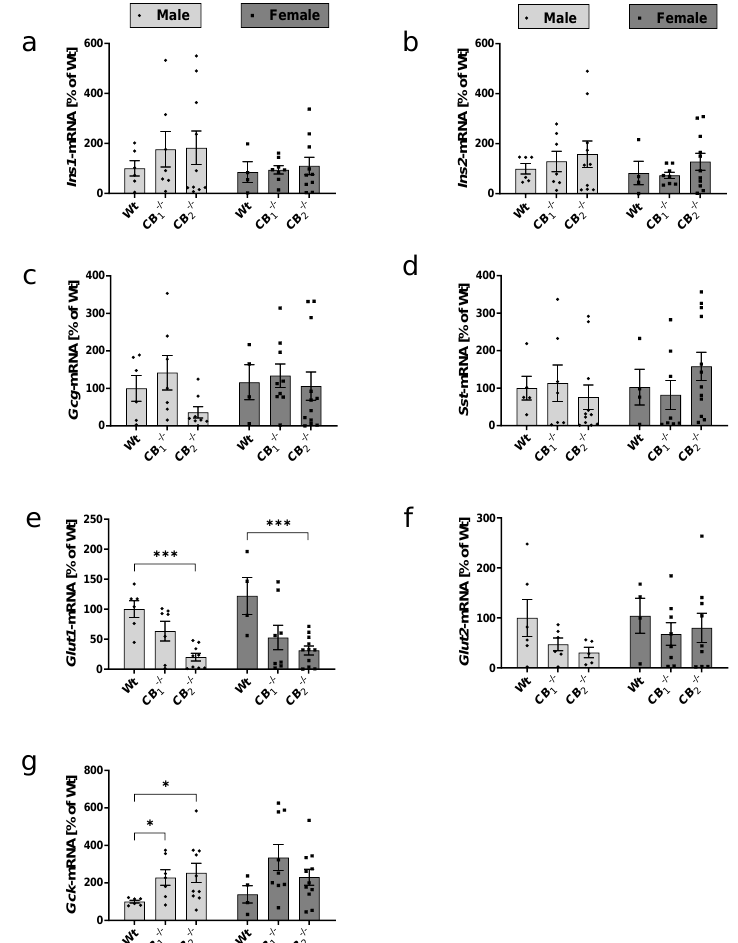
Figure A1. Transcript analysis by real-time RT-PCR of the pancreatic islet hormones ( Ins1 , Ins2 , Gcg and Sst ), glucose transporters ( Glut1 , Glut2 ) and glucokinase ( Gck ) analysing male and female wild-type (Wt) mice and cannabinoid receptor knockout mouse lines (CB 1 − / − , CB 2 − / − ) separately. No statistical significant differences were measured for Ins1 ( a ), Ins2 ( b ), Gcg ( c ) and Sst ( d ) between male and / or female Wt and knockout mice. ( e , f ) Transcript analysis of glucose transporters showed downregulation of Glut1 as well as Glut2 for both sexes in knockout mice. ( g ) Gck mRNA was upregulated in knockout lines of both sexes. Values are presented as mean ( ± S.E.M.) with n = 4–12 mice per group defining Wt values as 100%. * p < 0.05; *** p < 0.001 for comparisons between male or female Wt and knockout mice; unpaired t